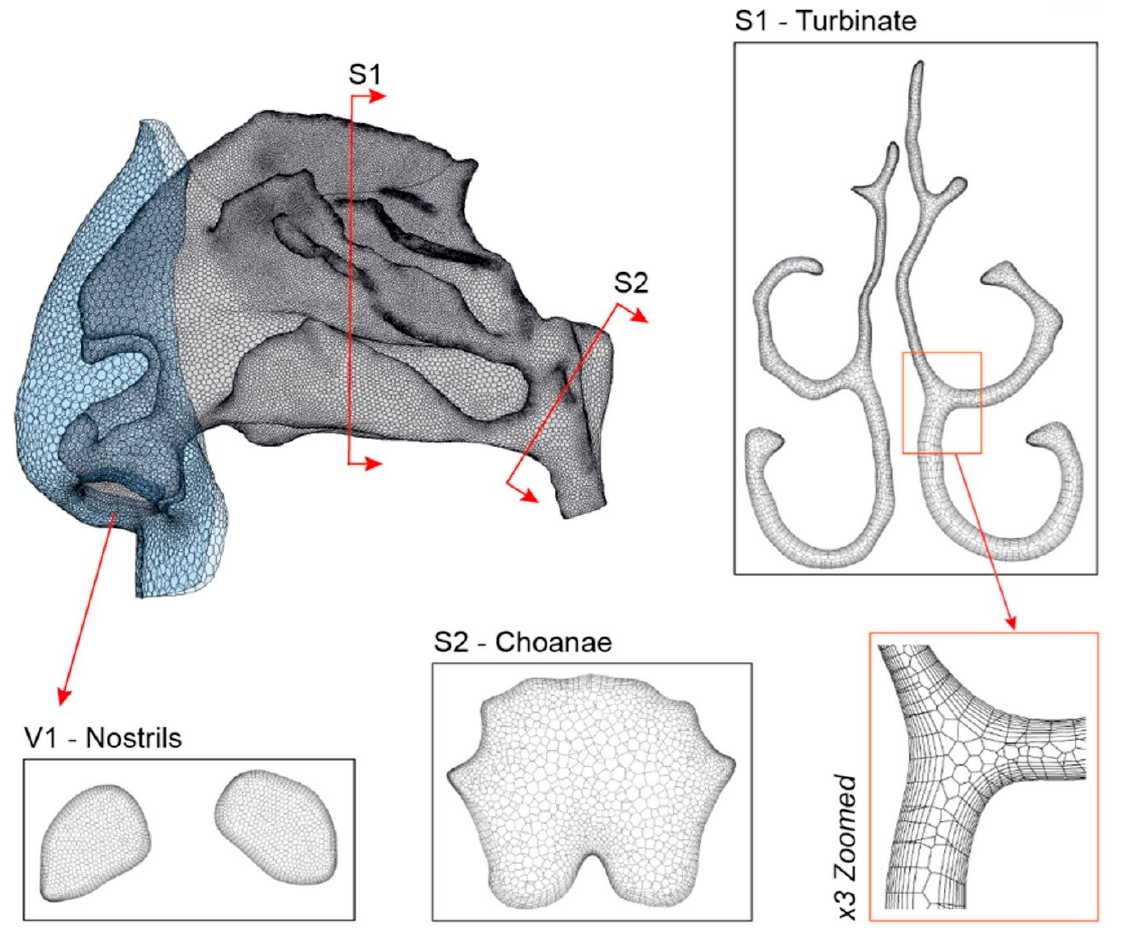
Figure 2. The hybrid prism-polyhedral computational mesh: V1—the nostrils, S1—the nasal turbinate and S2—the choanae.